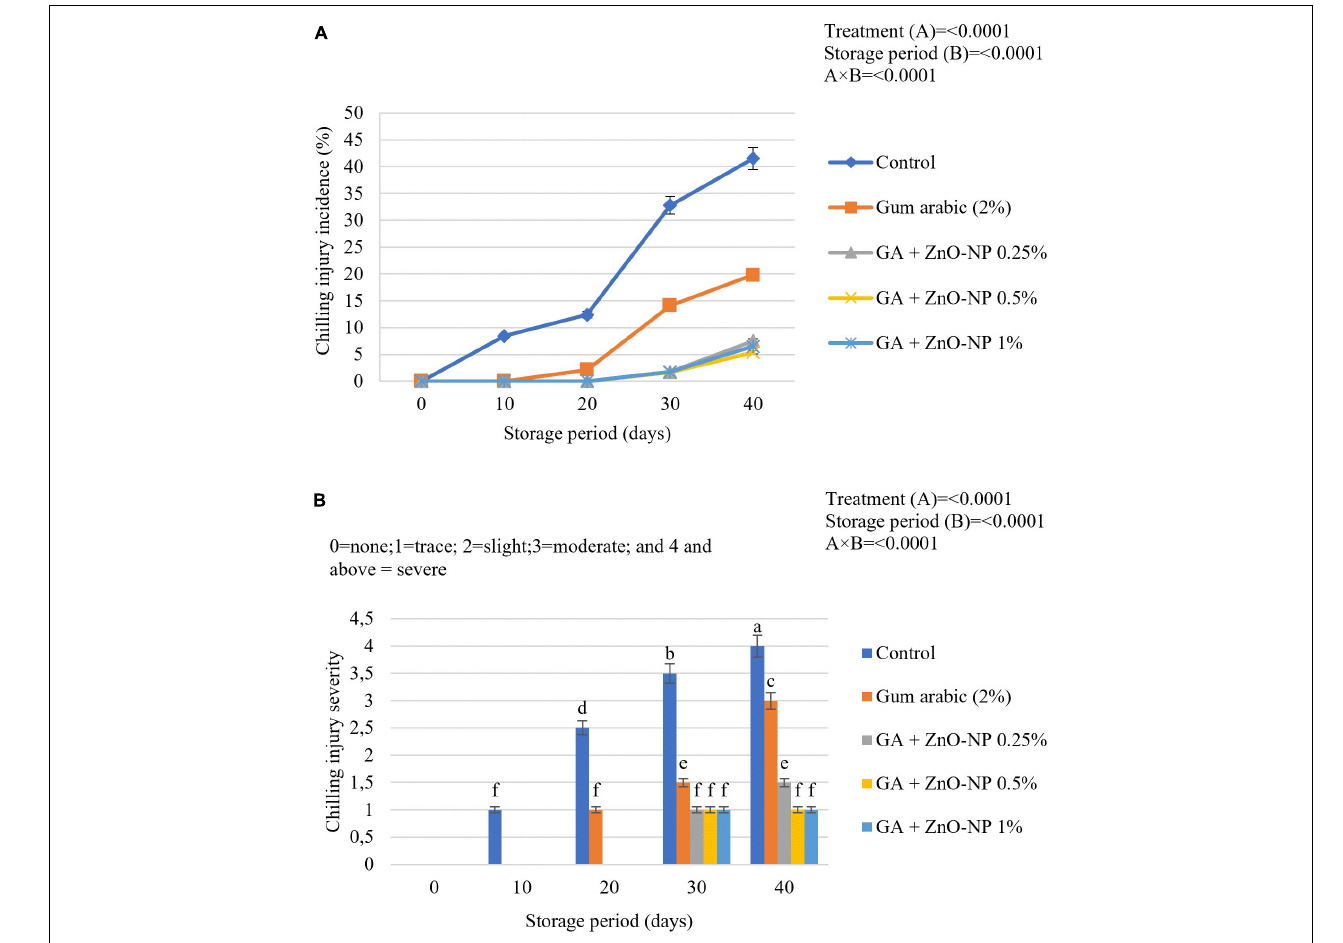
FIGURE 11 | (A) Chilling injury incidence and (B) chilling injury severity of ‘Kinnow’ mandarin fruit during storage for 40 days at 5 ± 1 ◦ C and additional 5 days at 20 ± 5 ◦ C. Error bars denote the standard error (SE) of the mean. Means ± standard errors presented. To determine the interaction effects, factorial ANOVA was performed for the main factors, treatment, and storage time. GA + ZnO-NP, gum arabic + zinc oxide nanoparticles. Bars followed by different letters are significantly different at p < 0.05 according to Duncan’s multiple range